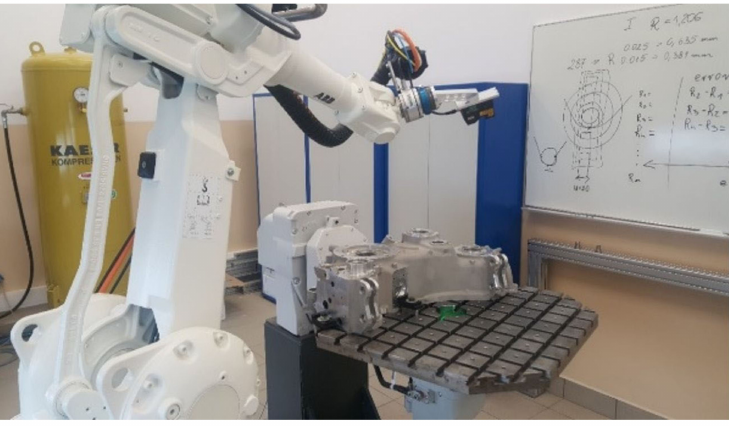
Figure 8. Robotised